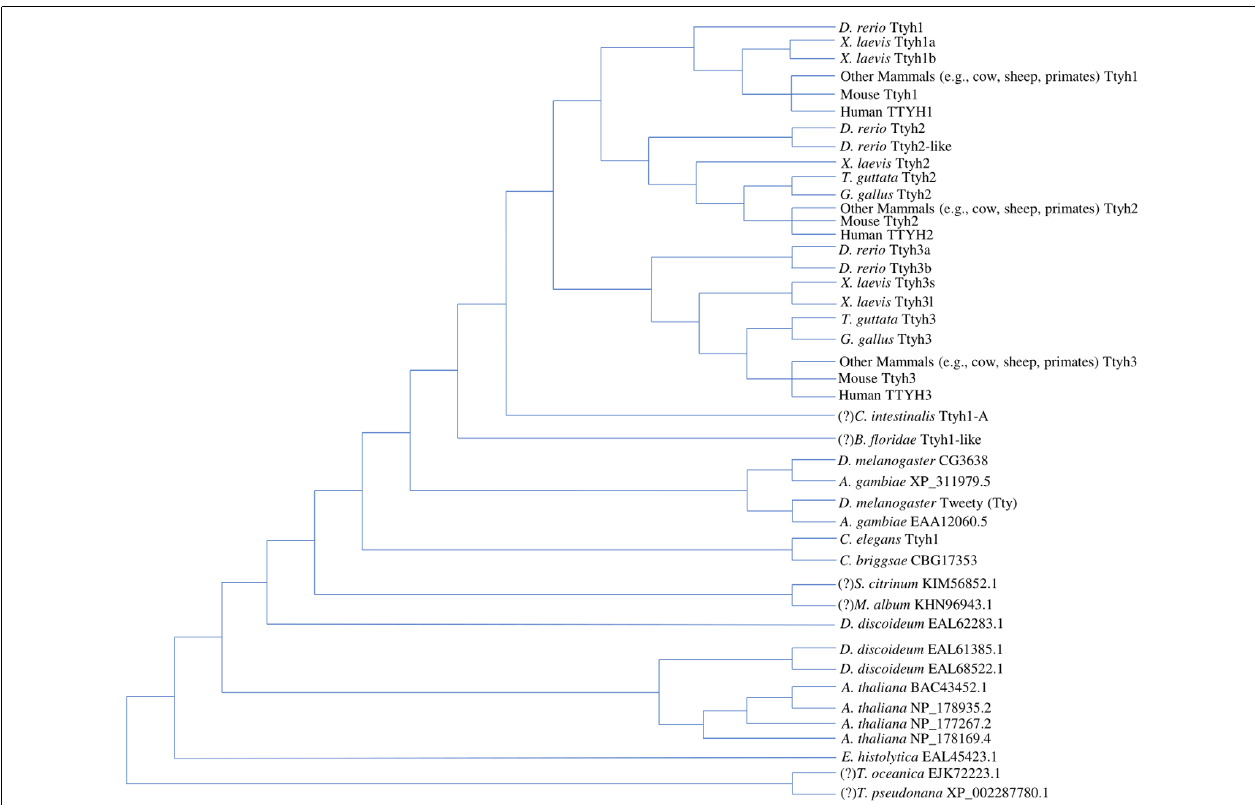
FIGURE 1 | Tree diagram depicting the Tweety protein homologs identified across multiple lineages based on phylogenetic analyses by past literature. The positions of potential orthologs identified by OrthoDB are assumed based on a revised eukaryotic tree incorporating multiple phylogenomic studies, while the positions of potential amphioxus and tunicate Tweety homologs identified through BLAST searches are assumed based on the current understanding of chordate evolution (Donoghue, 2017; Kriventseva et al., 2019; Burki et al., 2020). These have been labeled with a “(?)” in front of the species name. Multiple duplication events lead to the three Tweety paralogs found in most vertebrate species, while other eukaryotes have varying numbers of homologs (Campbell et al., 2000; Matthews et al., 2007; Han et al., 2019). The diagram does not attempt any phylogenetic analyses between the homologs and is only a summary of the findings by past literature and potential homologs identified through database searches. Protein accession numbers not included in the diagram are given in the Supplementary Material (Supplementary Accession Numbers; NCBI Resource Coordinators, 2018; https://www.ncbi.nlm.nih.gov/protein).